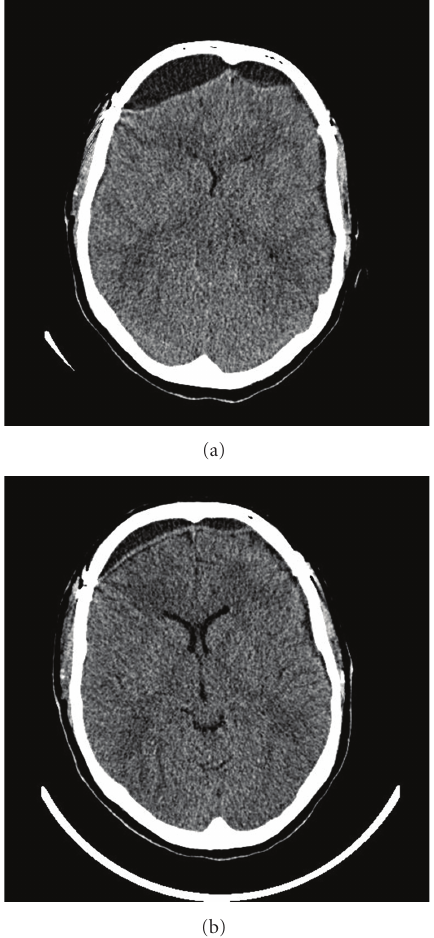
Figure 1: (a) Head CT of our patient the day before the EBP was performed. CSF leak resulted in large bifrontal fluid collections. (b) Head CT of the same patient the day after the EBP. The extradural CSF collection is significantly smaller in size. A possible explanation for this finding is the e ff ect of the EBP on the intracranial pressure (as evidenced by the increased intraventricular space) prohibiting further leakage through an existent frontal tear on the